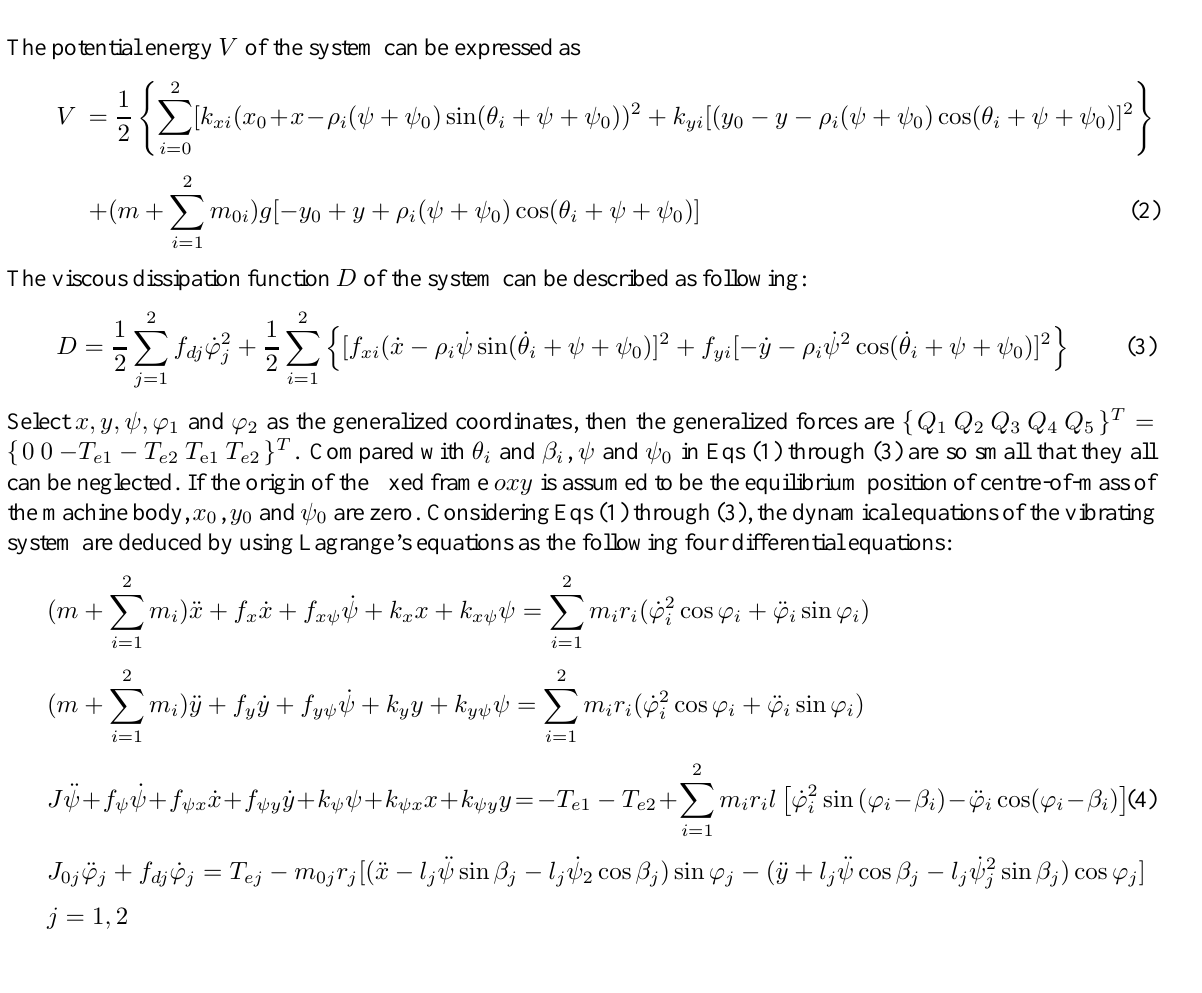
Fig. 1. Dynamic model of a vibrating system with two exciters asymmetrically